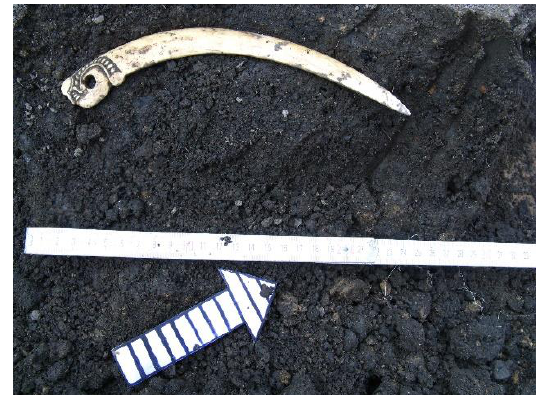
Figure 4. Mikulovice (Pardubice Region), “V loučkách” site. Bone part of a horse harness originating from Black Sea region (7 th – 6 th century BC). Proof of long-distance contacts and the only finding of this kind in our territory.